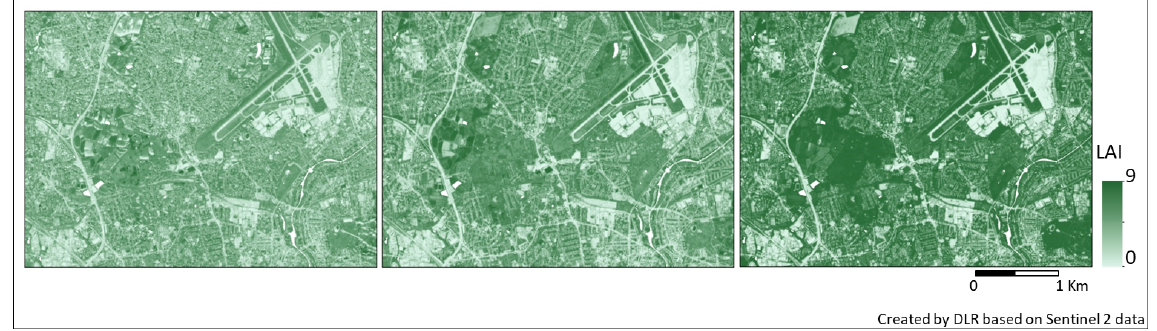
Figure 9. LAI for a subset of Hamburg in winter (14 February 2017, left), spring (20 April 2017, centre) and summer (23 August 2017,